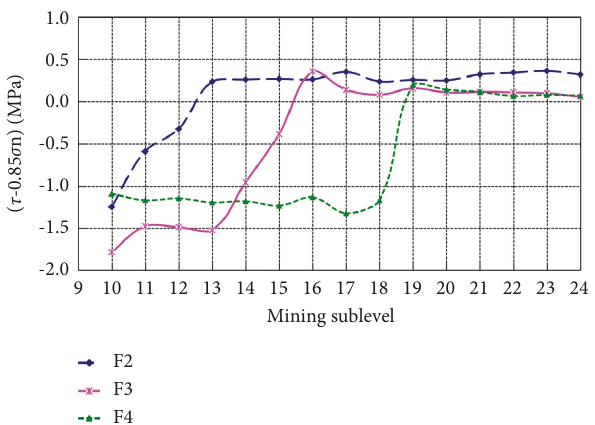
Figure 24: Temporal and spatial relationship curves of fault F2, F3, and F4 values changing with mining depth.